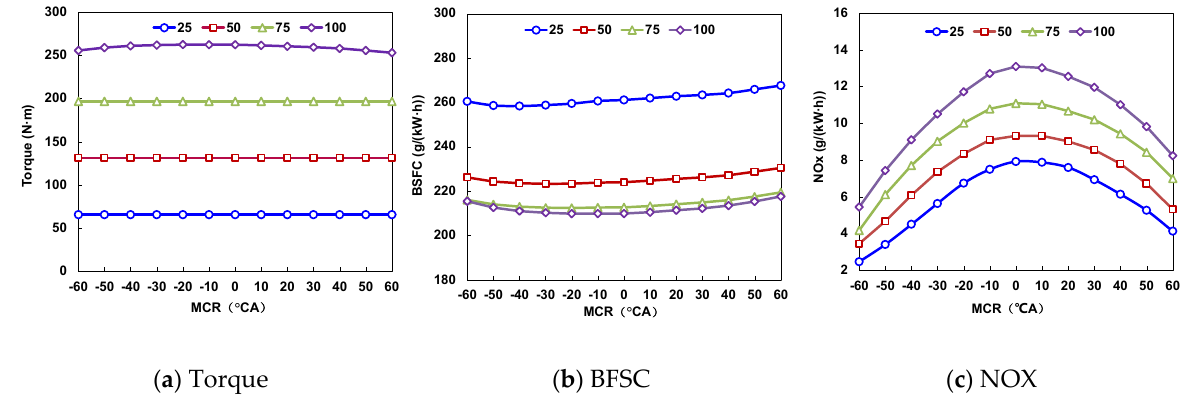
Figure 4. Effect of MCR on the diesel engine torque, BFSC, and NOx under different loads.